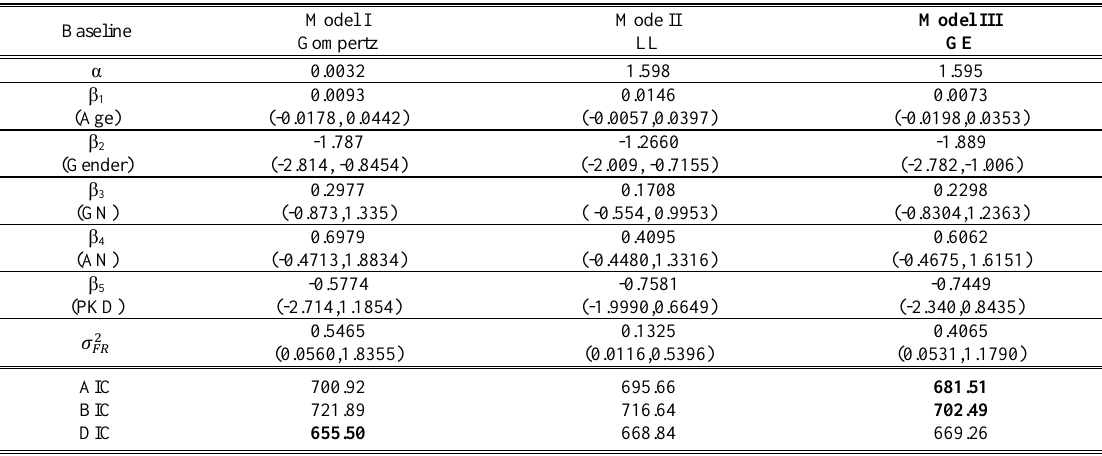
Table 2. Parameter estimates (credible intervals) of CI dataset under the generalized gamma shared frailty